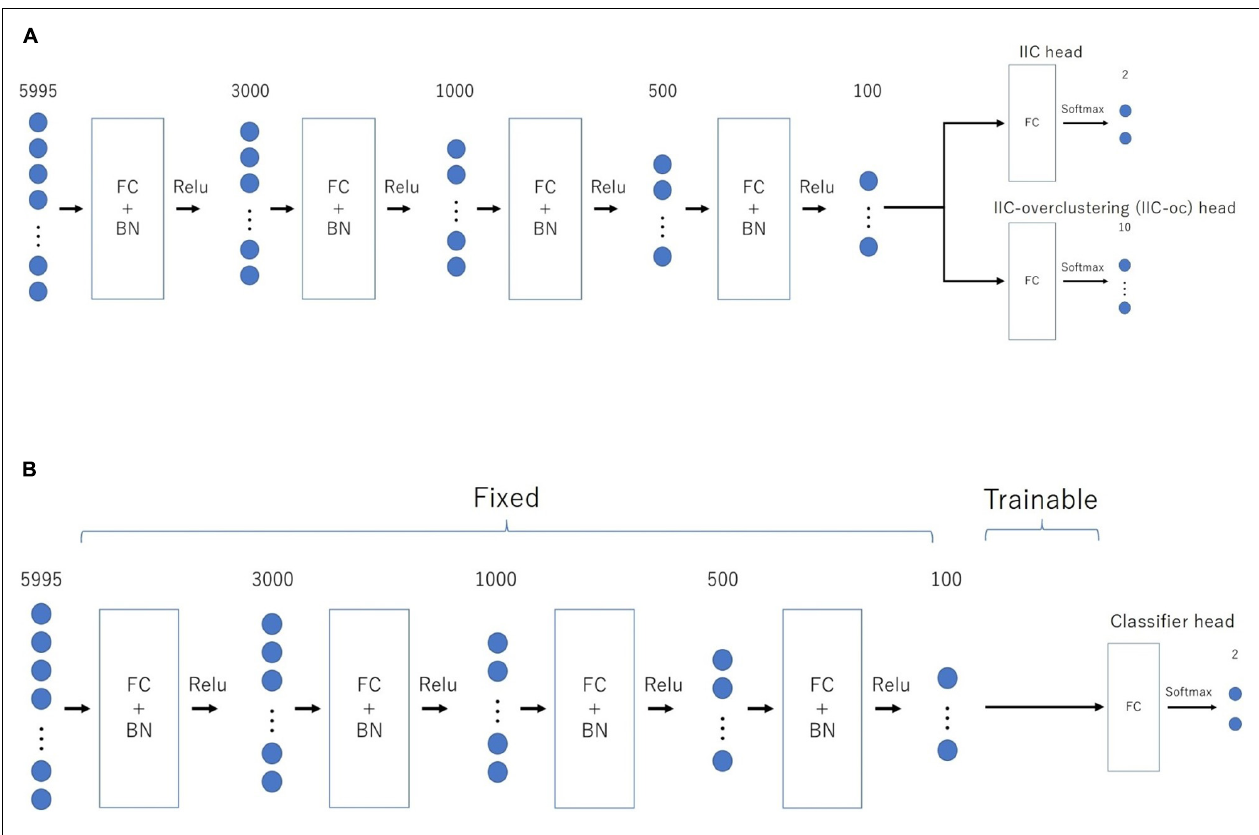
FIGURE 1 | Architecture of the two-step EIIC mechanism. (A) Contrastive prior learning (simple IIC structure) for the first step; (B) transfer learning with IIC for the second step. IIC, invariant information clustering. EIIC, extended invariant information